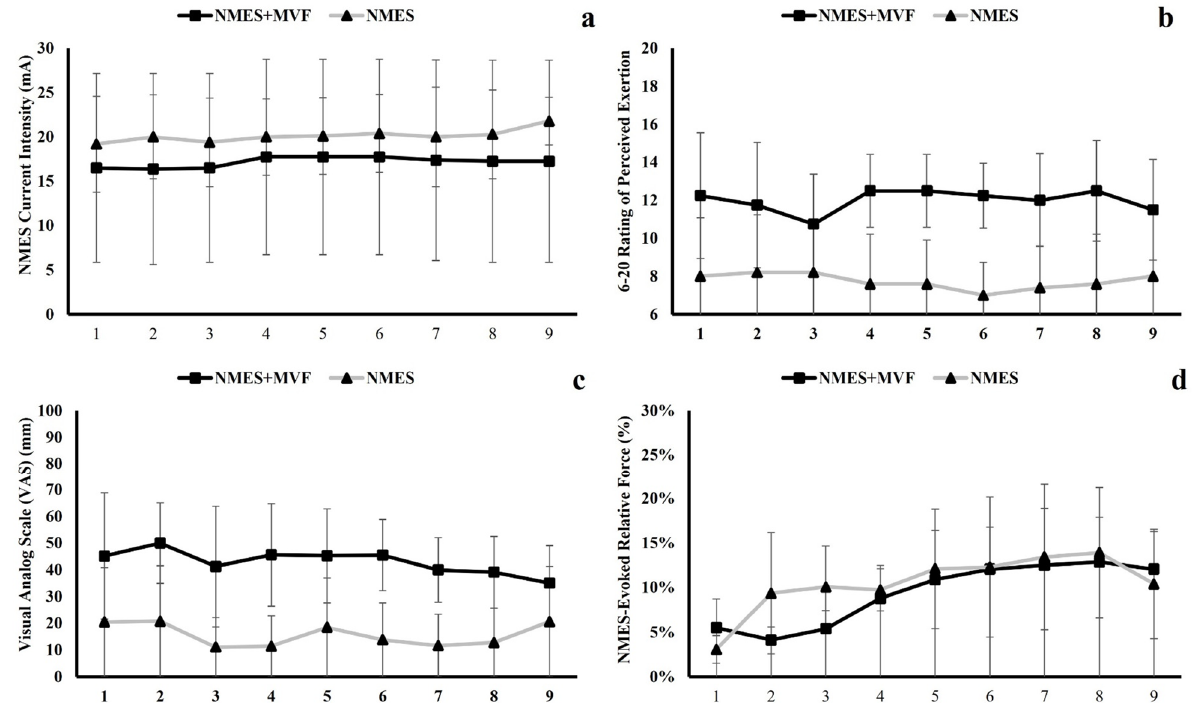
Figure 3. Changes of the mean stimulation current intensity ( a ), RPE ( b ), NMES-induced discomfort (VAS) ( c ), and NMES-evoked relative force ( d ) for both NMES + MVF and NMES groups across the 9 training sessions.